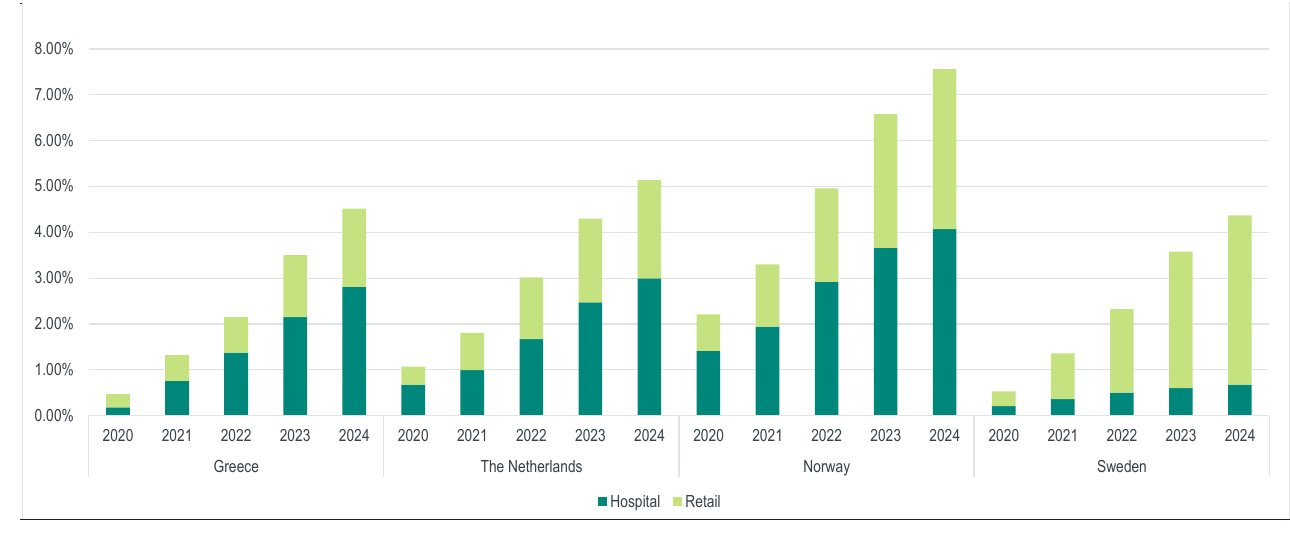
Figure 2. Average Budget Realized as a Share of Total Annual Drug Budget